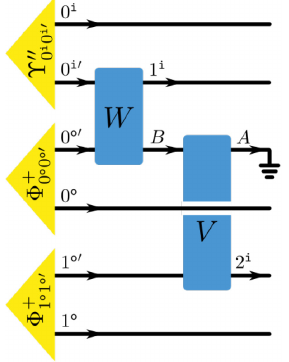
FIG. 21. Dilation of the Choi state of a process tensor. Up to normalization, Eqs. (192) and (193) together yield a quantum circuit for the implementation of the Choi state of a two-step pro- cess tensor that consists only of pure states and isometries (which could be further dilated to unitaries).